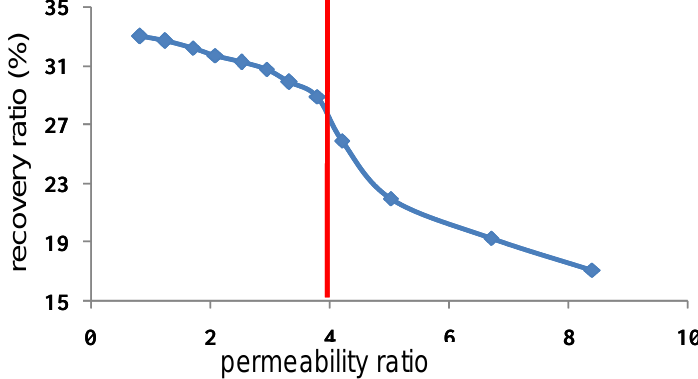
Figure 4—Relation curve between recovery and permeability